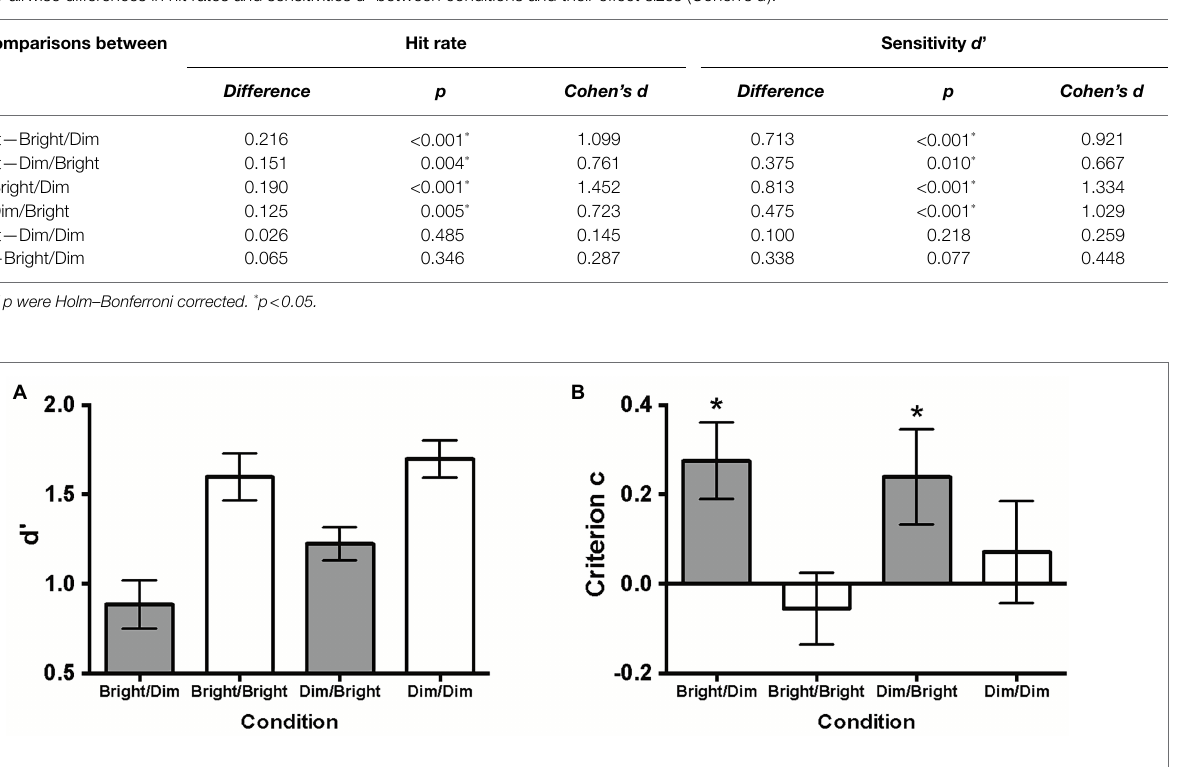
FIGURE 2 | (A) Sensitivity d’ and (B) criterion c (indicating response bias) across the four conditions. All error bars represent ±1 SEM. The asterisks (*) in (B) represent c significantly different from zero. Conservative response biases were found in both incongruent lighting conditions (Bright/Dim &